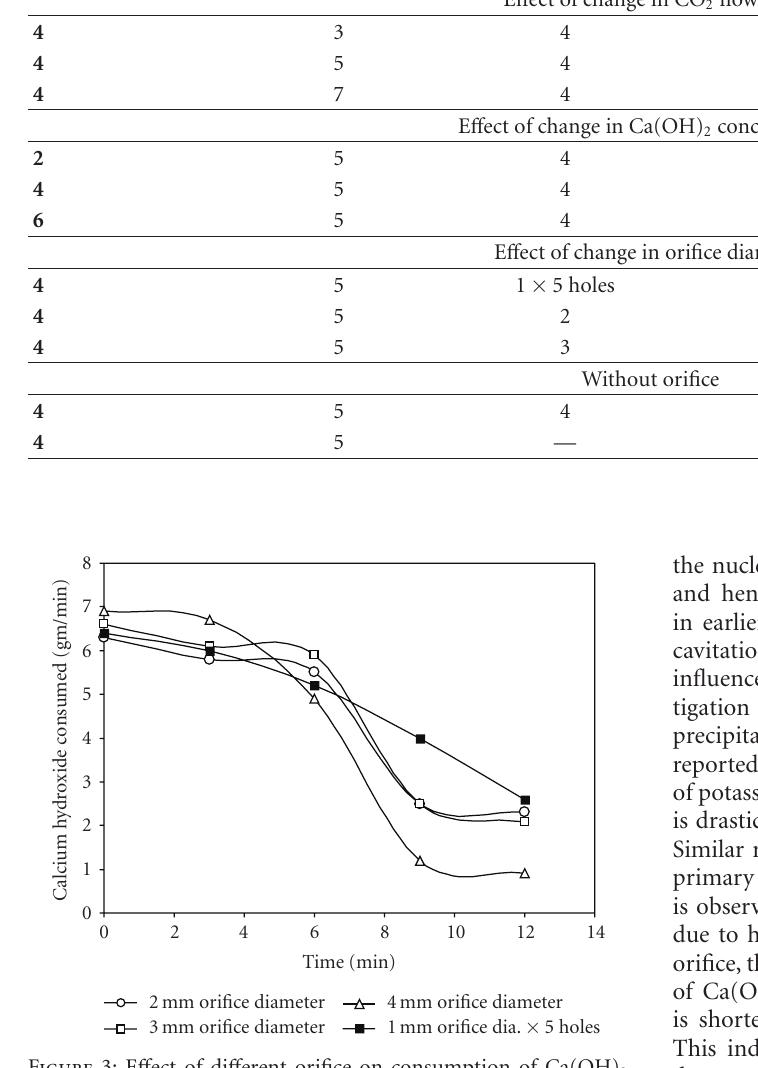
Figure 3: E ff ect of di ff erent orifice on consumption of Ca(OH) 2 Slurry with respect of time (showing constant rate period and falling Rate periods) (4% Ca(OH) 2 and 5l/min Co 2 flow